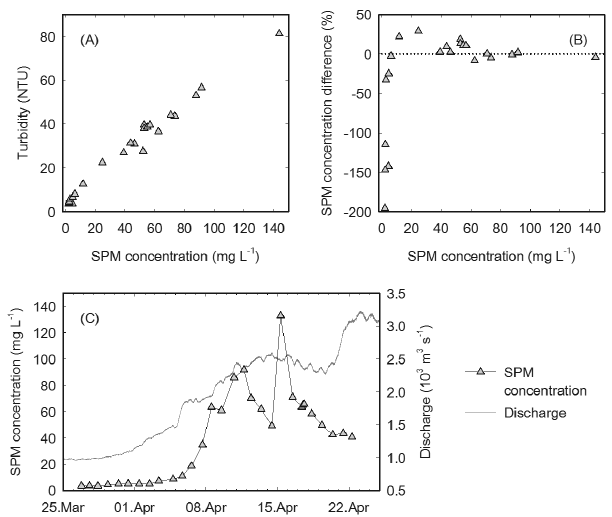
Figure 2. (a) Measured suspended particulate matter (SPM) con- centration determined from the mass of sediment recovered from filtered water correlated strongly with turbidity measured with a nephelometer. (b) SPM concentration difference was calculated as the difference between the SPM concentration determined from the mass of sediment recovered from filtered water and that estimated from the linear correlation in panel (a) . (c) Suspended sediment con- centrations increased rapidly during the early freshet